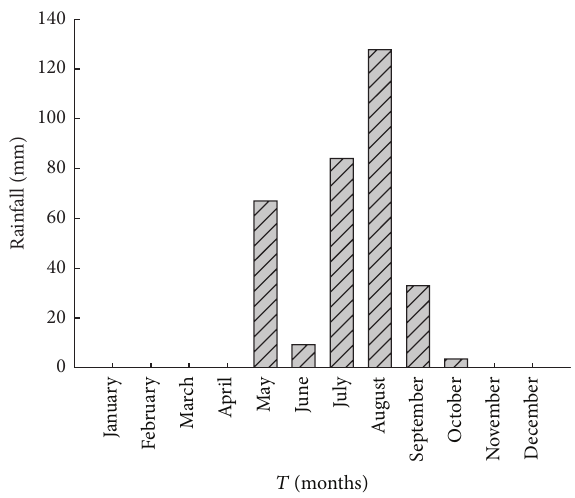
Figure 2: Monthly rainfall in the study region in 2011. different treatments were tested by one-way ANOVA and LSD using SPSS 12.0 (SPSS Inc., Chicago, IL, USA).